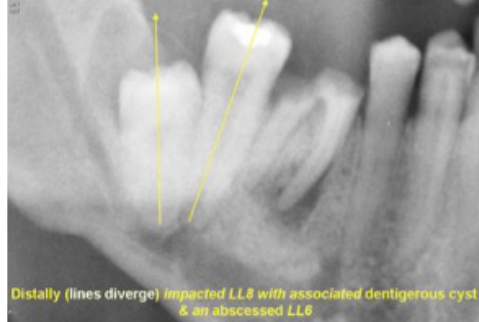
2. Disto-­‐Angular (Figure 2): The long axis of the 3rd molar is angled distally or posteriorly away from the second molar. 3. Horizontal (Figure 3): The long axis of the third molar is hori-­‐ zontal. 4. Vertical (Figure 4): The long axis of the third molar is par-­‐ allel to the long axis of the second molar. 5. Buccal / Lingual Obliquity (Figure 5): The tooth can be buccally (tilted